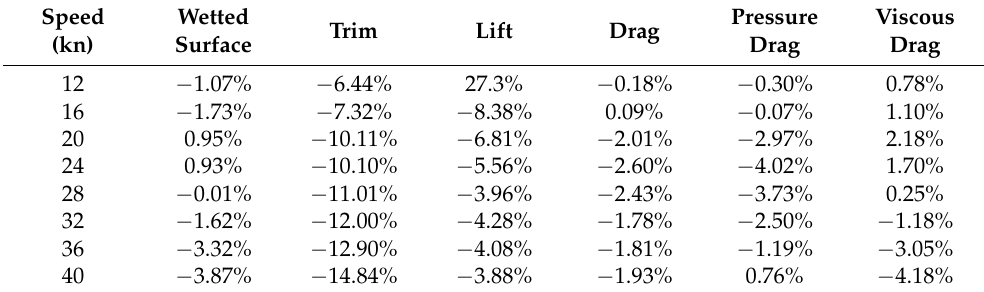
Table 13. Relative difference of global quantities: V1 vs. V2.